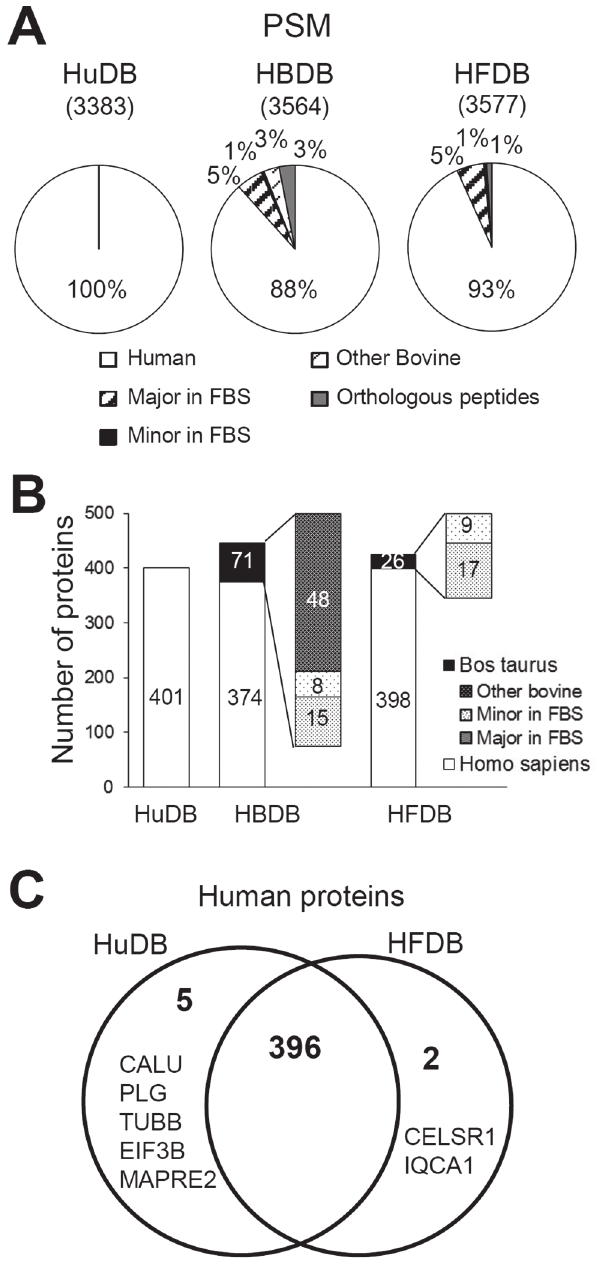
Fig 2. Search results of MS/MS data from Calu-1 secretome analysis vary depending on the database used. (A) PSMs are classified based on their species specificity. The classifications are PSMs belonging to: the top 30 FBS proteins or the proteins identified from residual FBS in the media or on the surface of the plate (Major in FBS), other FBS proteins (Minor in FBS), bovine proteins not identified by FBS analysis (Other bovine), and none of the species exclusively due to identical sequences (Orthologous peptides). (B) The number of identified proteins. Bovine proteins are subgrouped as in (A). (C) Venn diagram showing human proteins among the identified